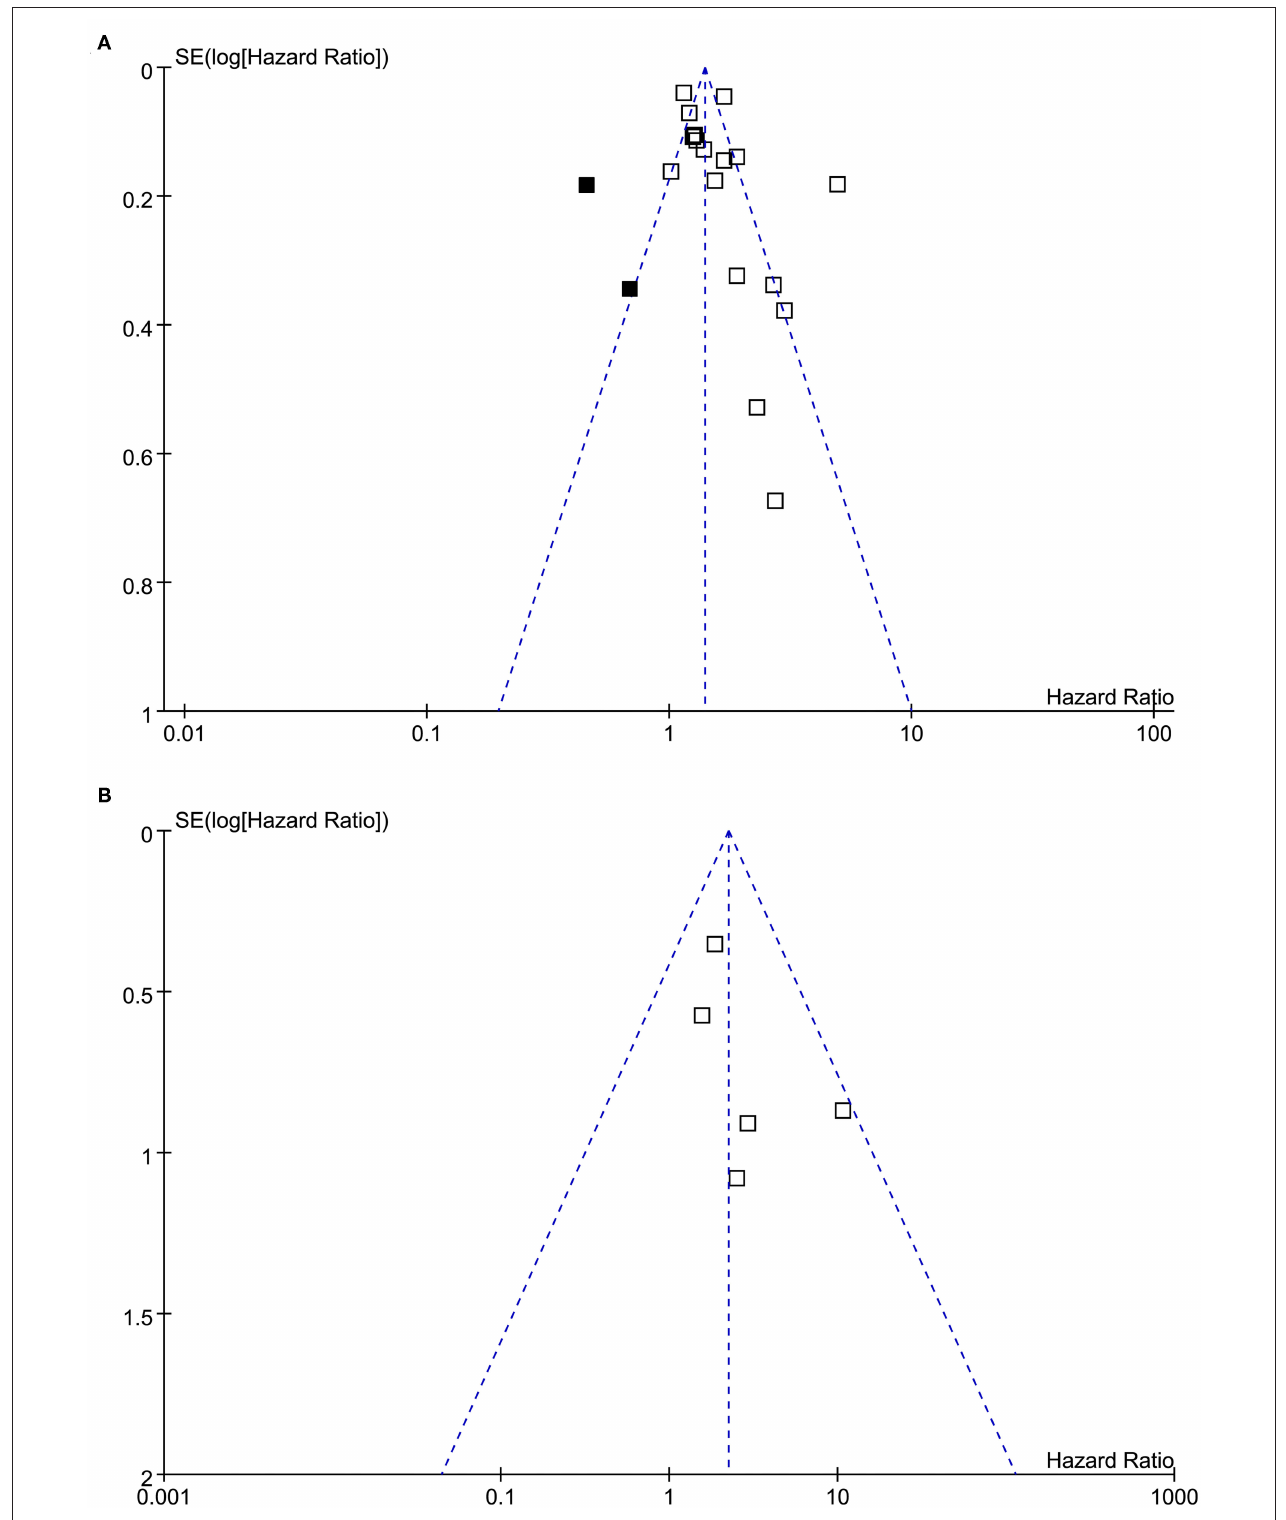
FIGURE 6 | Funnel plots for the meta-analyses. (A) Funnel plots with trim-and-fill analysis for the meta-analysis concerning the association between hearing loss and the incidence of all-cause dementia (black square indicates hypothesized studies to achieve the symmetry of the funnel plots). (B) Funnel plots for the meta-analysis concerning the association between hearing loss and the incidence of